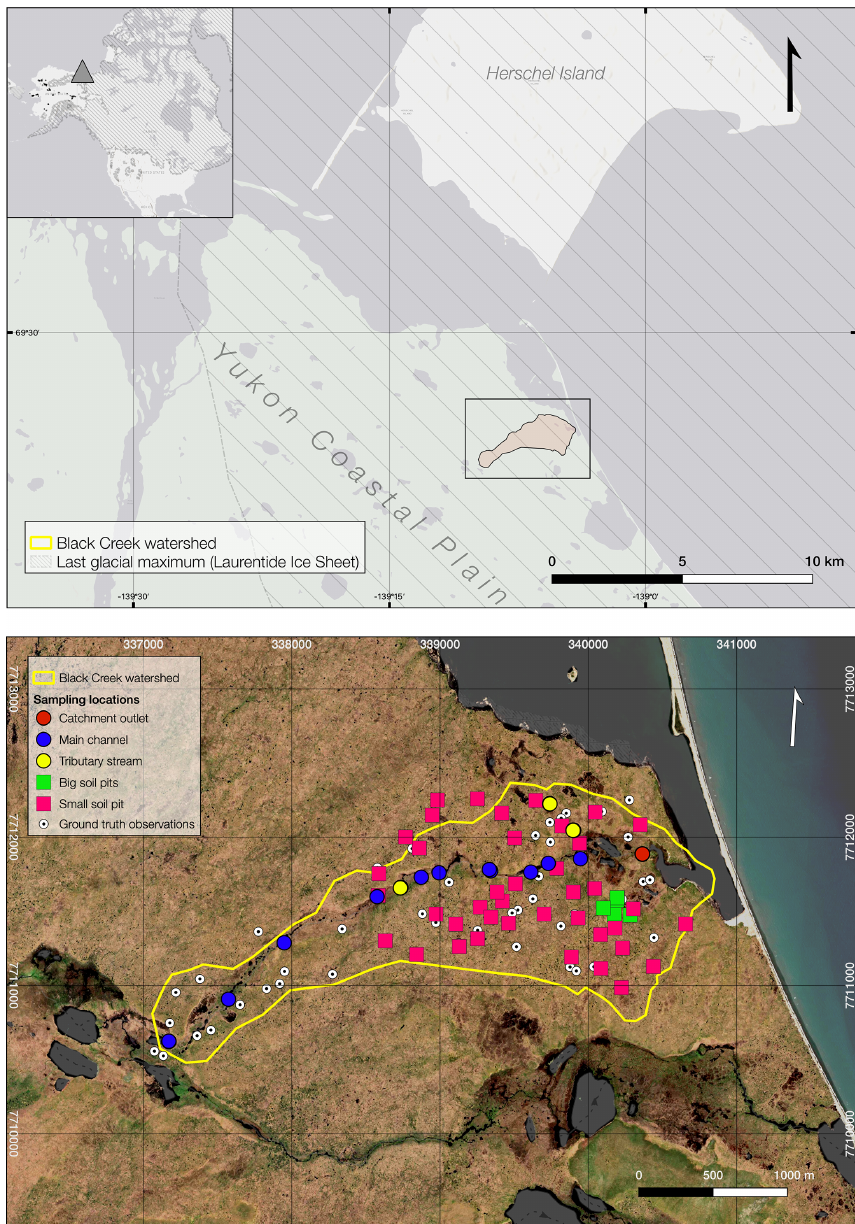
Figure 1. Location of Black Creek watershed on the Yukon Coastal Plain (upper panel) and detailed catchment image showing the different sampling locations and sampling types (lower panel) (satellite imagery: WorldView-2, DigitalGlobe Inc., acquired on 18 July